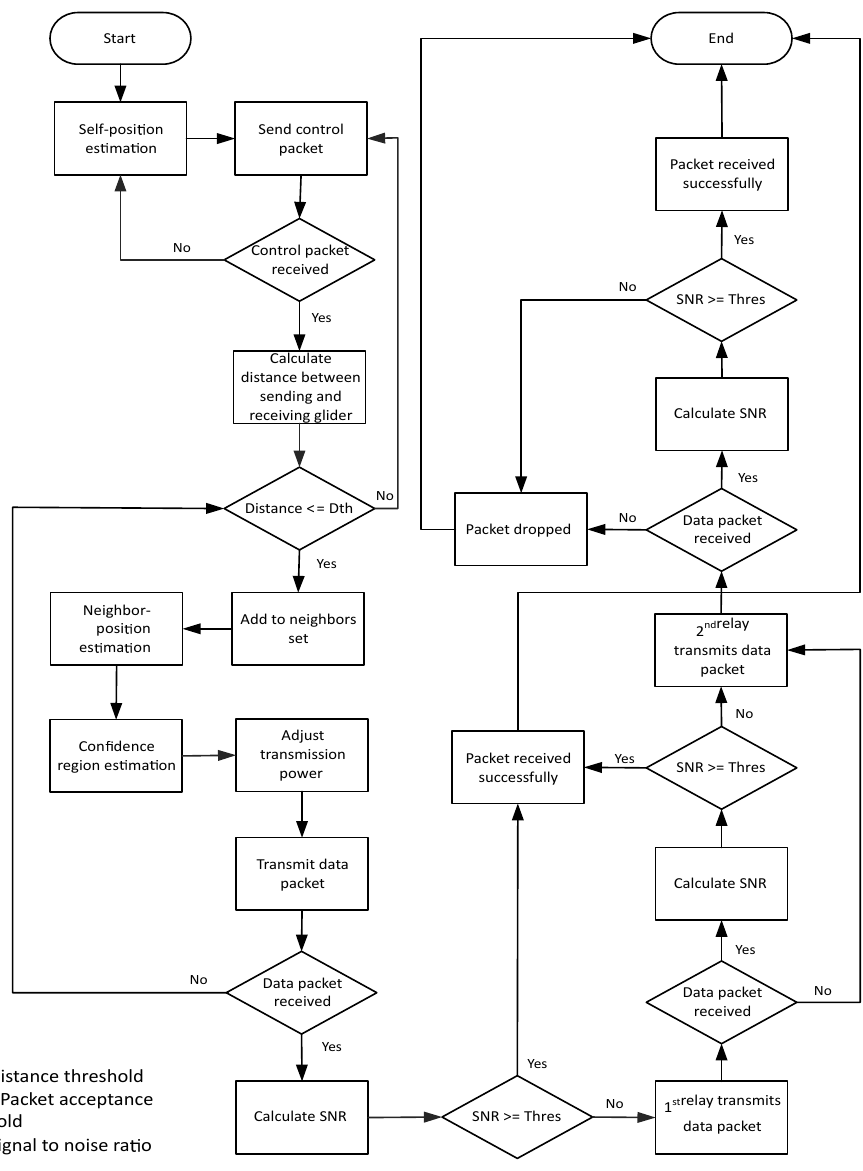
Figure 6. Protocol operation of Co